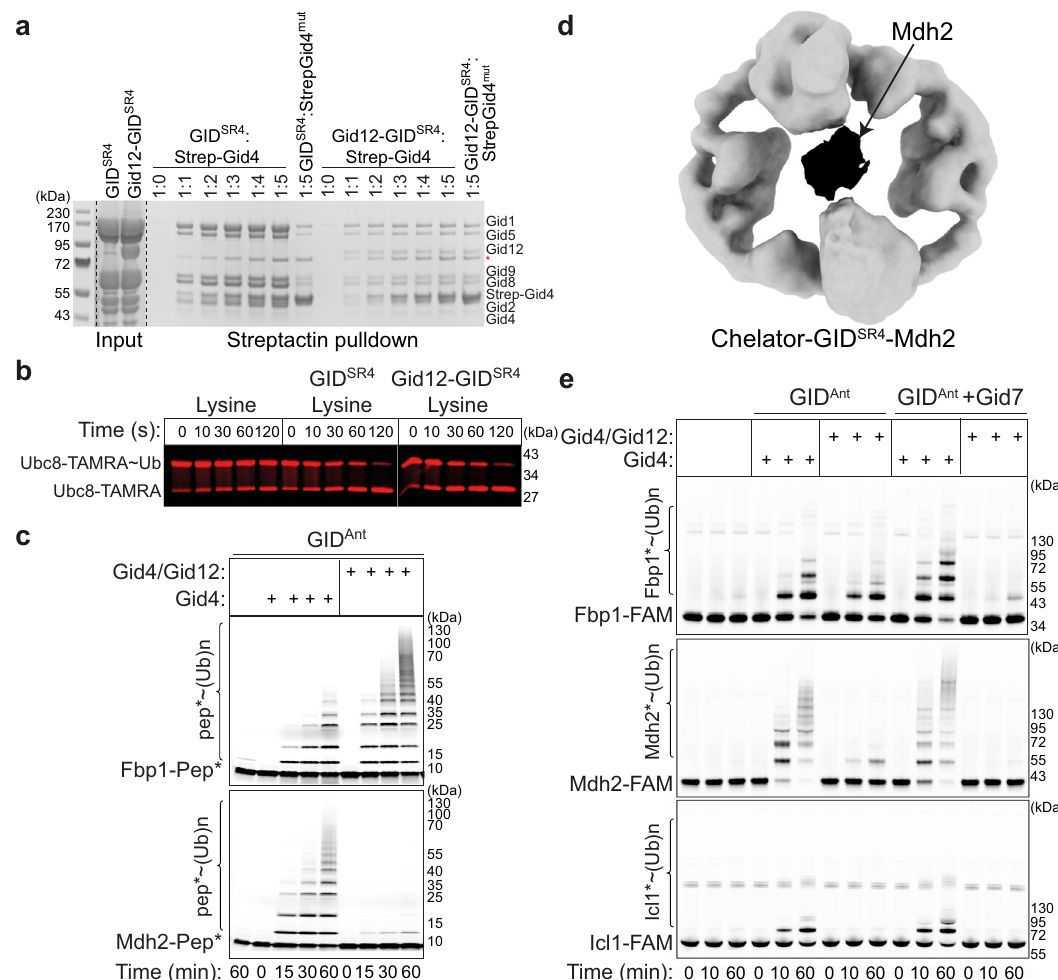
Fig. 6 Gid12 biochemically modulates both assembly of Gid4 into the GID E3 ligase complex and its activity toward its substrates. a Strep-tagged Gid4 in solution can replace untagged Gid4 within GID SR4 but not in the Gid12-bound complex. A mutant (mut) lacking the C-terminal four residues 359 – 362 required for incorporation into GID SR4 is used as a control for speci fi city of Strep-Gid4 incorporation into the complex ( n = 3 biologically independent experiments). b Pulse chase assay examining effects of Gid12 on GID ubiquitin transferase activity in substrate-independent manner. Ubc8 is C-terminally fl uorescently labeled with TAMRA for fl uorescence detection of the free E2 versus the version thioester-linked to Ub. First, the thioester-linked Ubc8- TAMRA~Ub intermediate was generated in a pulse reaction. Second, the chase reaction monitors formation of the faster-migrating Ubc8-TAMRA upon Ub discharge to free lysine, stimulated by GID SR4 with or without a bound Gid12 ( n = 3 biologically independent experiments). c In vitro ubiquitylation assay of model peptide substrates (with an N-terminal substrate degron, a fl exible linker, a single lysine at optimal position to accept ubiquitin, and a C-terminal fl uorescein for fl uorescent detection) testing effects of adding puri fi ed Gid4 alone or Gid4 co-expressed with Gid12 to GID Ant ( n = 3 biologically independent experiments). d 18.9 Å-resolution cryo-EM density map of Chelator-GID SR4 -Mdh2. Mdh2 dimer encapsulated in the oval center of Chelator- GID SR4 is color-coded in black. e Experiment as in ( c ), except with the indicated full-length metabolic enzyme substrates, each appended to a C-terminal fl uorescein for fl uorescent detection ( n = 3 biologically independent